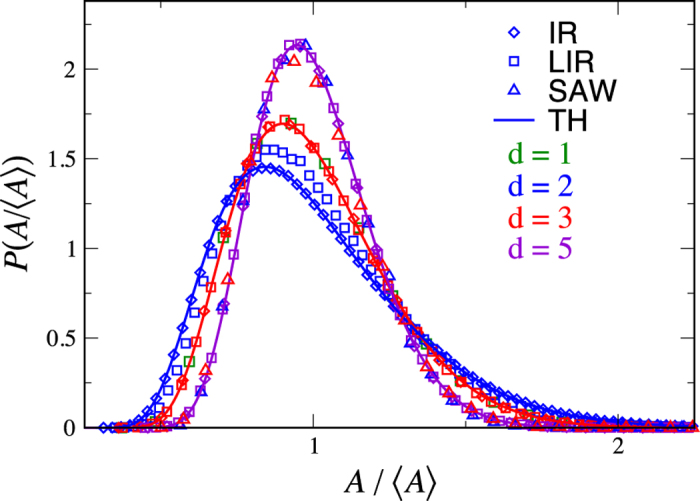
Theoretical P+(A/〈A〉)Eq. (10) in dimensions d = 3, 5 nicely matche simulations of the ideal ring (IR) and the local interaction (LIR) models.In d = 2, however, agreement with theory for the local interaction model is poorer due to critical slowing down (the simulations did not converge for N = 106, see text). The theoretical curves (solid lines) for the two models are identical for d ≥ 2. The d = 1 LIR theory is identical to the d = 3 theory, which the simulation confirms. The SAW simulations in d = 2, 3 are practically indistinguishable from each other and from the theoretical curve corresponding to an ideal ring in dimension d = 5. The shape of the symbol indicates the model simulated (square = LIR, diamond = IR, triangle = SAW). The lines correspond to theory. The color indicates the dimension (green = 1d, blue = 2d, red = 3d, violet = 5d).